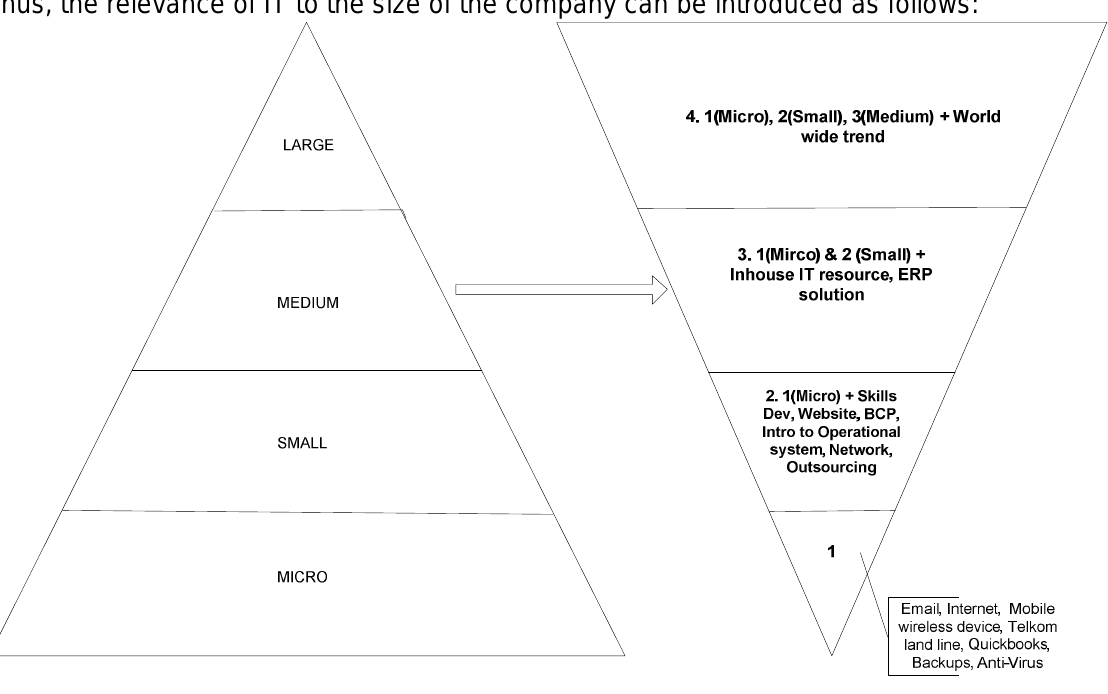
Figure 2: IT relevance